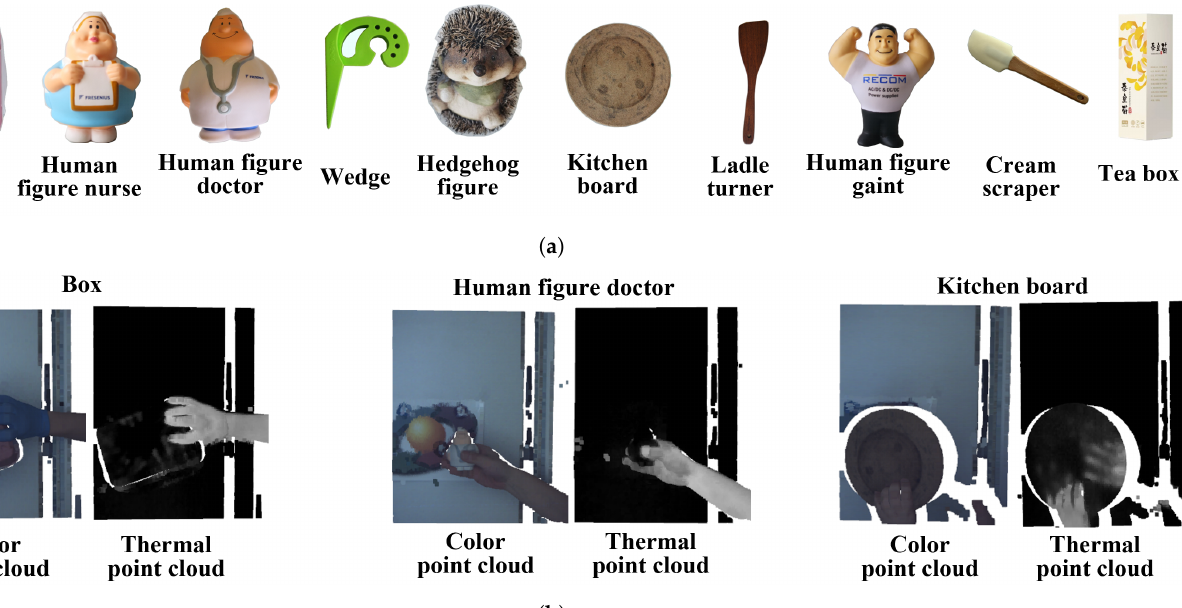
Figure 7. Overview of the GOBO-Dataset with 12 classes (10 objects, background, and hand): ( a ) all objects; ( b ) examples of multimodal 3D data (Box, Human figure doctor, and Kitchen